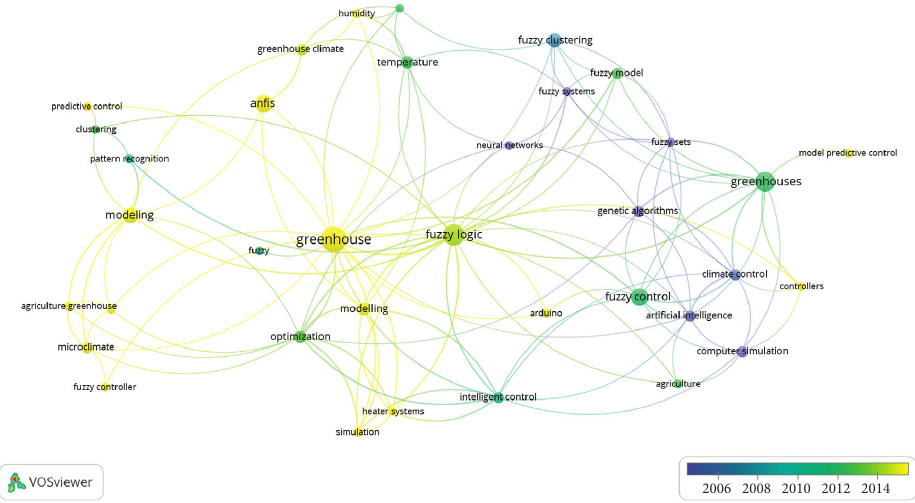
Figure 4: Keyword’s co-occurrence map analysis.